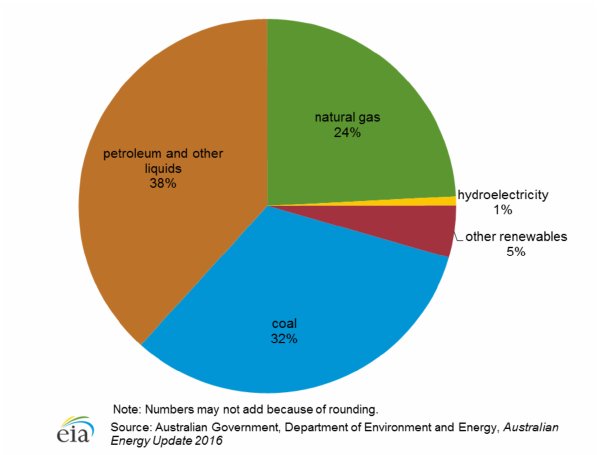
Figure 1. Primary energy consumption in Australia in 2015 [1].